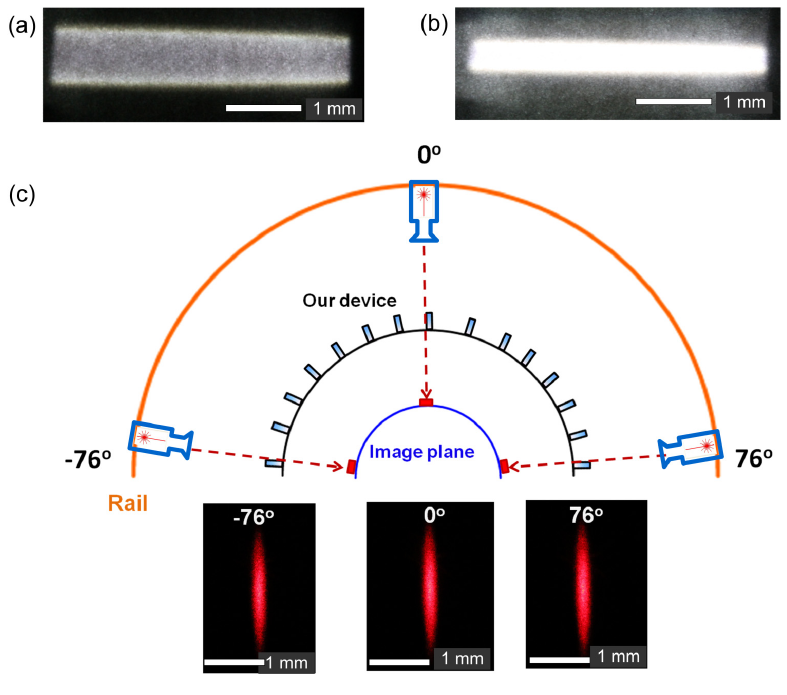
Figure 6. Focused line images produced by ( a ) a commercial plano-convex refractive cylindrical lens revealing strong chromatic aberration and ( b ) our device without chromatic aberration. These two images demonstrated clear evidence highlighting the distinctive differences in focused images with and without chromatic aberration due to different focusing mechanisms: refraction vs. reflection; ( c ) composite schematic and pictures representing 152° of FOV achieved by our device captured at three representative angles of incidence: − 76° (left), 0° (center) and 76°